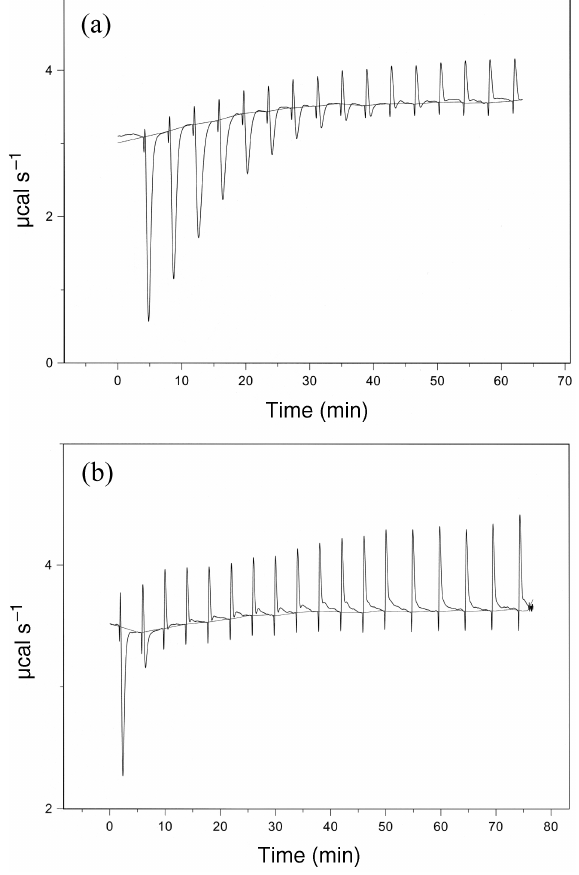
Figure4. Isothermaltitrationcalorimetry:(a) 94 µM carbamatekinase (CK) titrated into a solution of 10 µM ornithine carbamoyl transferase (OTC) in macromolecular crowding conditions, 20 mM phosphate buffer with 7.5% PEG 12,000 at 55 °C; (b) 94 µM CK titrated into 20 mM phosphate buffer with 7.5% PEG 12,000 at 55 °C.